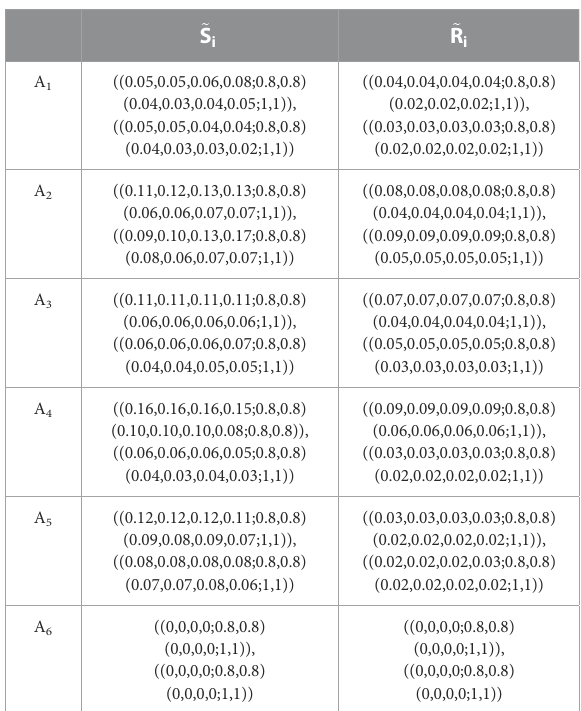
TABLE 7 Fuzzy best value and fuzzy worst value. TABLE 8 ~ S i and ~ R i .